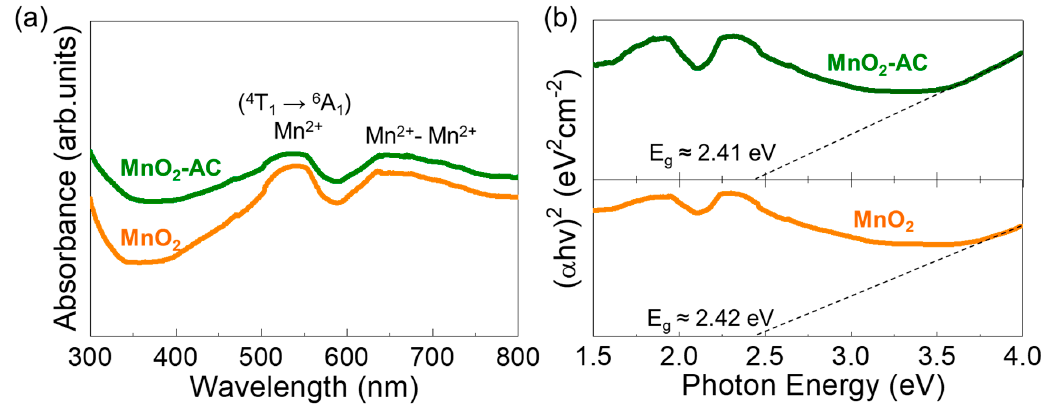
Figure 5. ( a ) UV ‐ VIS absorption spectra and ( b ) Tauc’s plots of MnO 2 nanoparticles and MnO 2 ‐ AC nanocomposites.